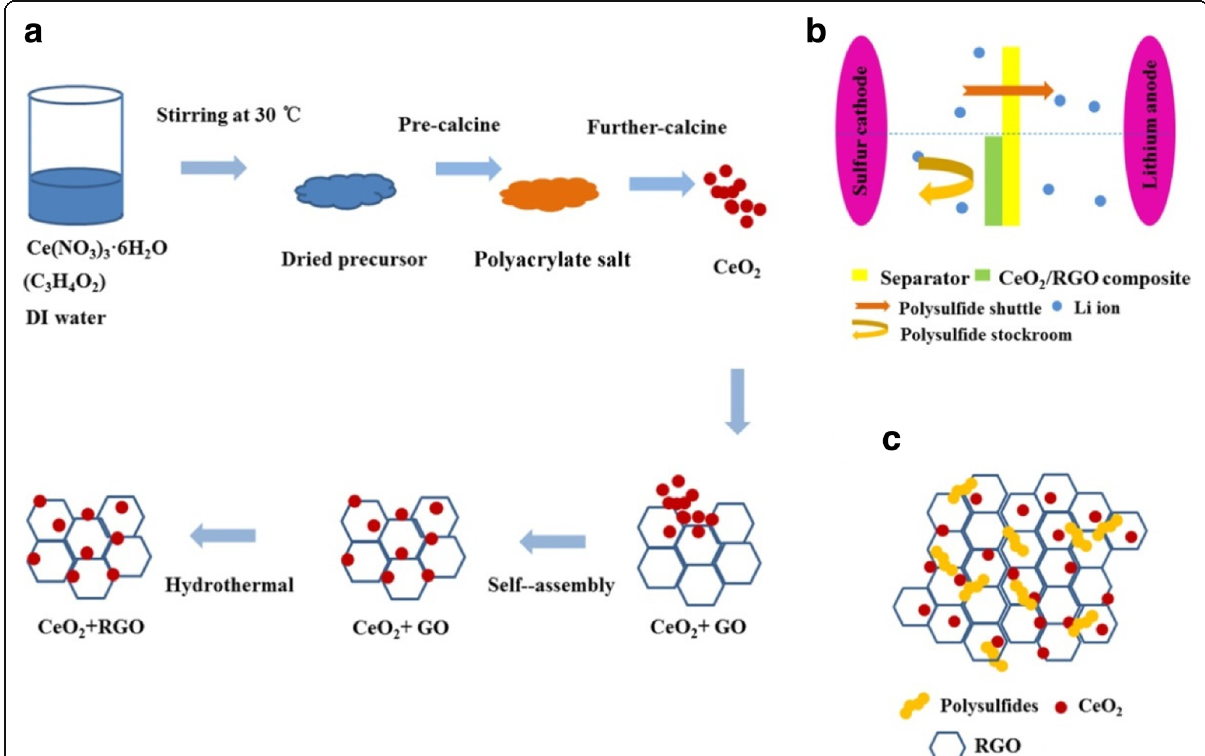
Fig. 1 A schematic illustration of fabrication process of CeO 2 /RGO composite ( a ). Scheme of the cell configuration with normal separator (top) and CeO 2 /RGO composite coated separator (bottom) ( b ). The functioning mechanism of CeO 2 /RGO composite coated separator ( c